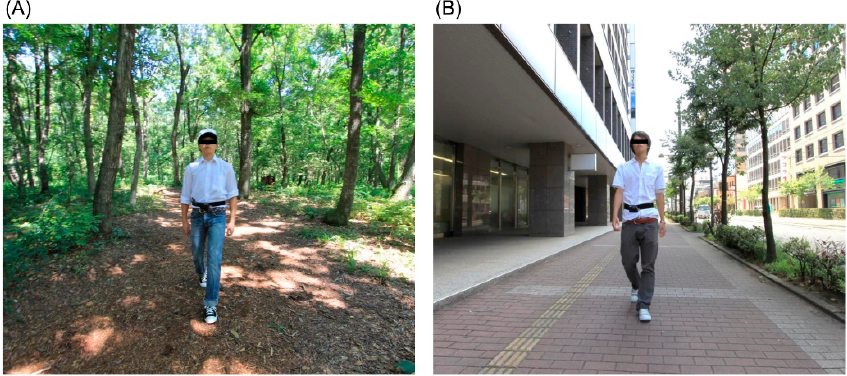
Figure 2. Experimental scenery. ( A ) Forest area and ( B ) city area.